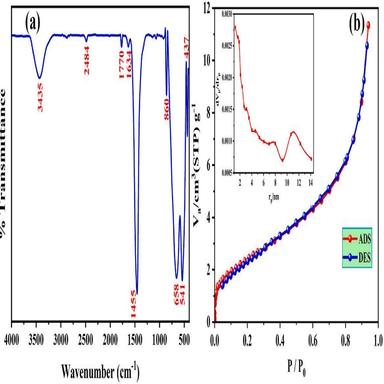
(a) FT-IR spectra of as-synthesized sample and (b) N2 adsorption/desorption isotherm, and BJH diagram (inset) of S1.